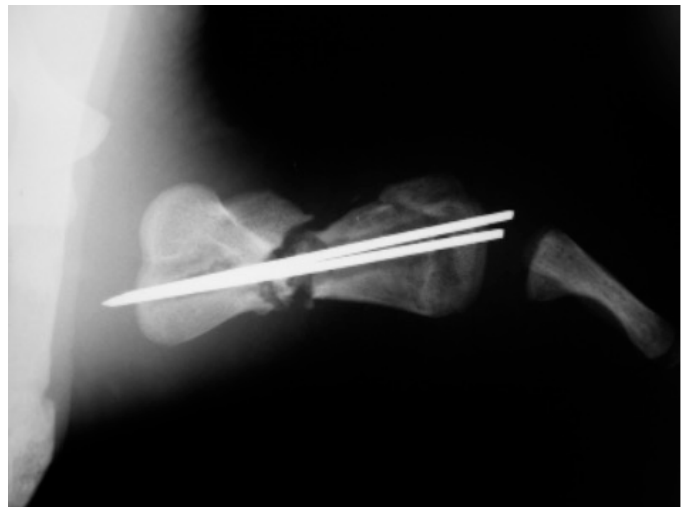
Figure 4. Two-month follow-up performed in caudocranial view of the anterior right flipper showing the filling of the diaphyseal fracture line .